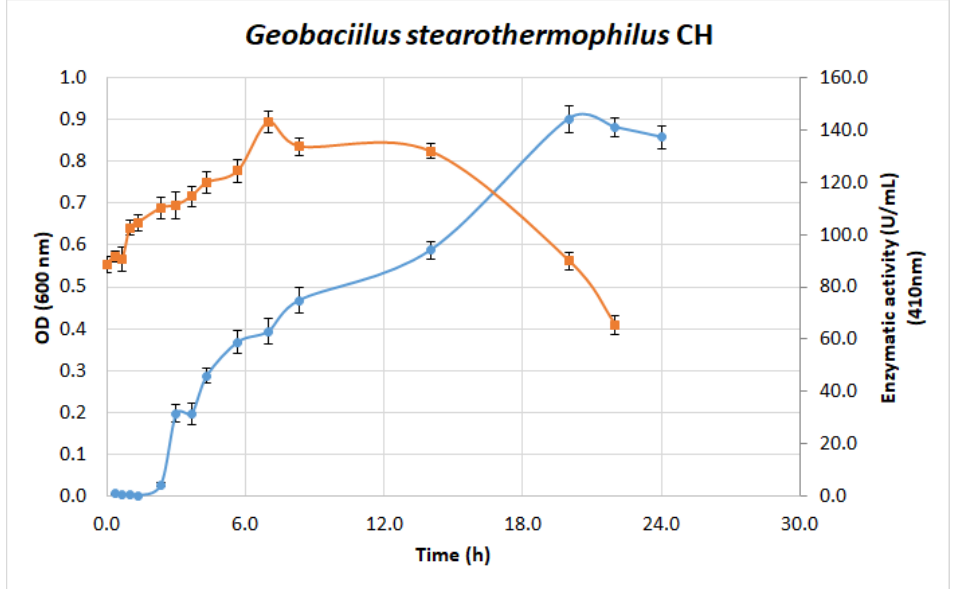
Figure 7. Biomass concentration (closed circles) and extracellular lipolytic activity (U/mL) (closed squares) of G. stearothermophilus CHI 1 culture in lipase production medium at 71.6 °C and pH 5.4.